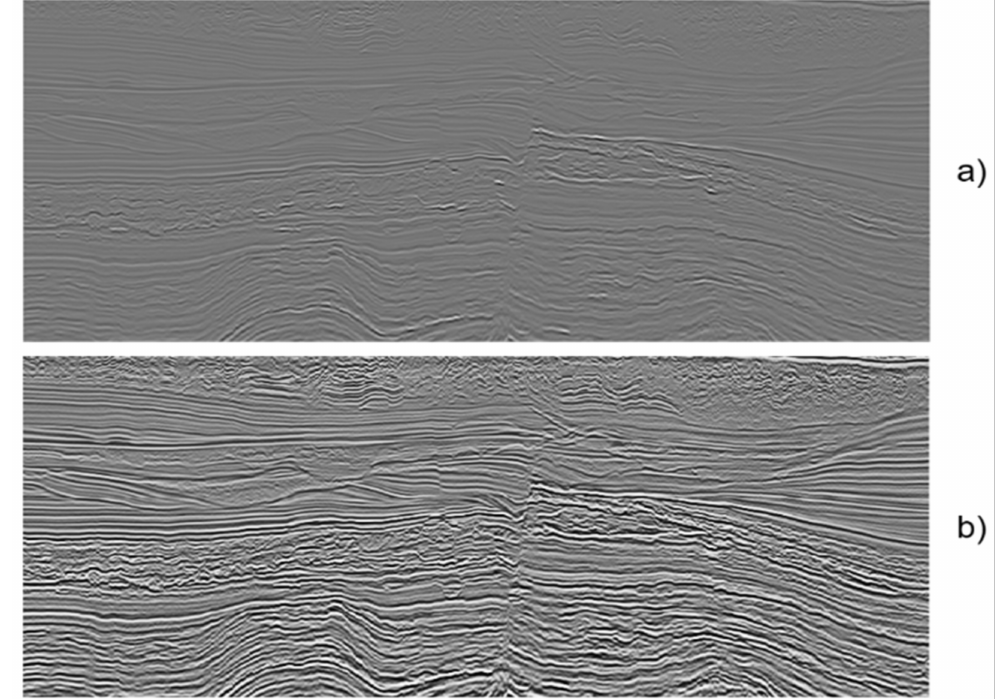
Figure 4. Example of results from the adaptive equalization on the seismic slice: ( a ) original seismic vertical slice, ( b ) seismic vertical slice after adaptive